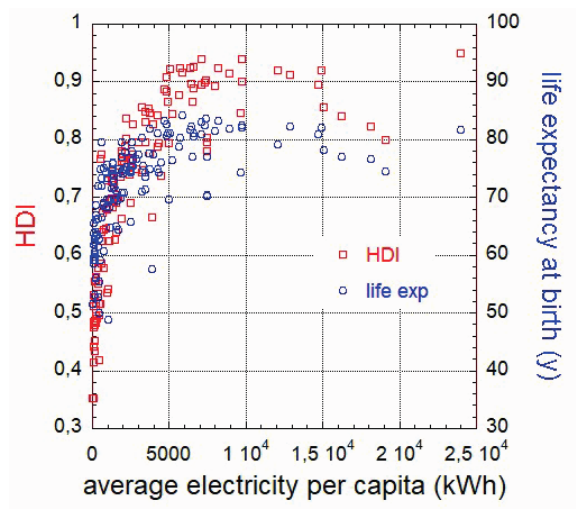
Fig. 3. – Human development index HDI, and “life expectation at birth” versus the electricity consumption per capita.